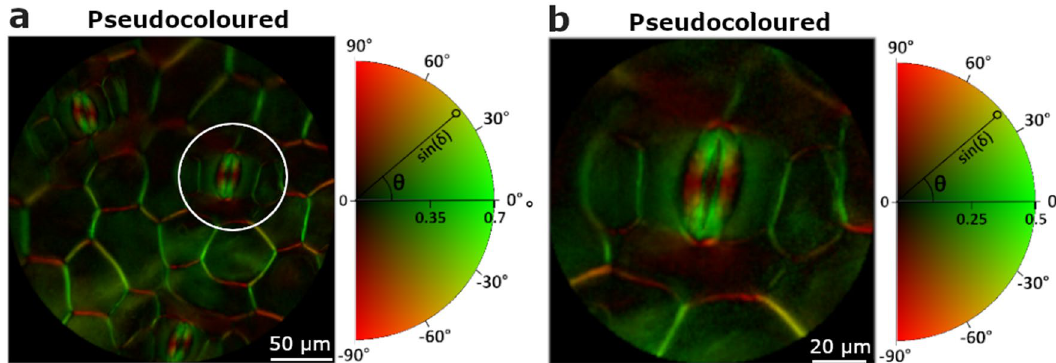
Figure 3. Pseudocoloured image of a collection of stomata and the zoomed image of a given stoma are shown in ( a ) and ( b ), respectively. The pseudocoloured image comprises the linear retardance information of the sample (shown into a white–black scale; radius of the semi-circular colour scale), and the fast axis orientation (represented with different colours; perimeter of the semi-circular colour